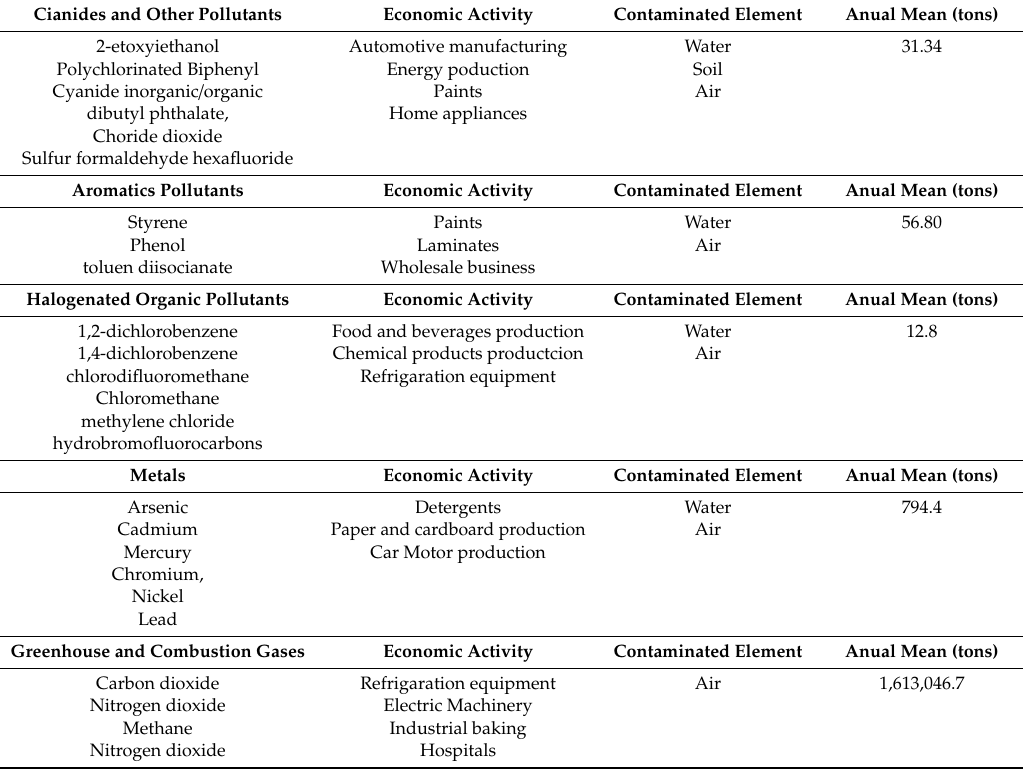
Table 1. Classification of the main industrial pollutants. Emission sources.